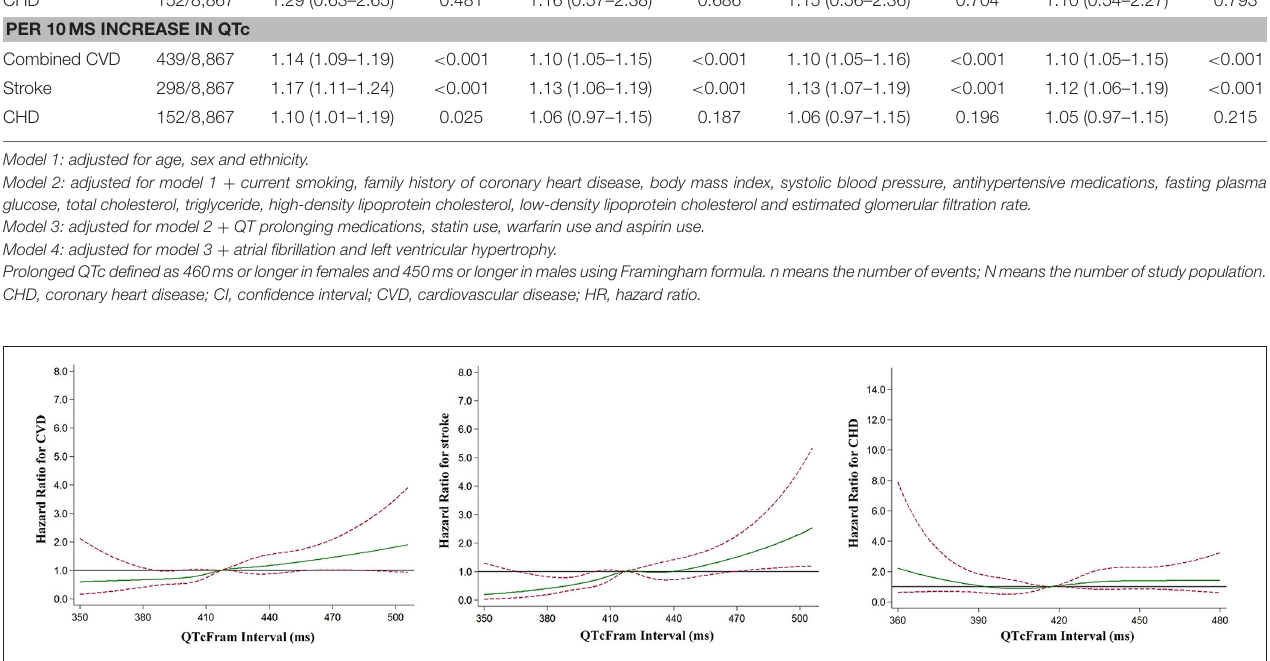
FIGURE 2 | Multivariable-adjusted restricted cubic spline analysis for the hazard ratio of cardiovascular events as a function of the QTc interval. The green solid line indicates multivariable-adjusted hazard ratios for cardiovascular events, and the red dashed lines indicate the upper and lower 95% confidence intervals. The horizontal black line indicates a hazard ratio of 1. Adjustment factors are as Model 4 in Table 2 . CHD, coronary heart disease; CVD, cardiovascular disease.